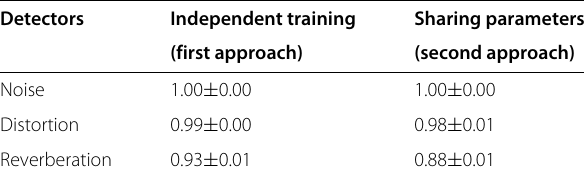
Table 2 The performance of the CNN128 system when no parameters were shared across detectors and when the parameters in some layers were shared